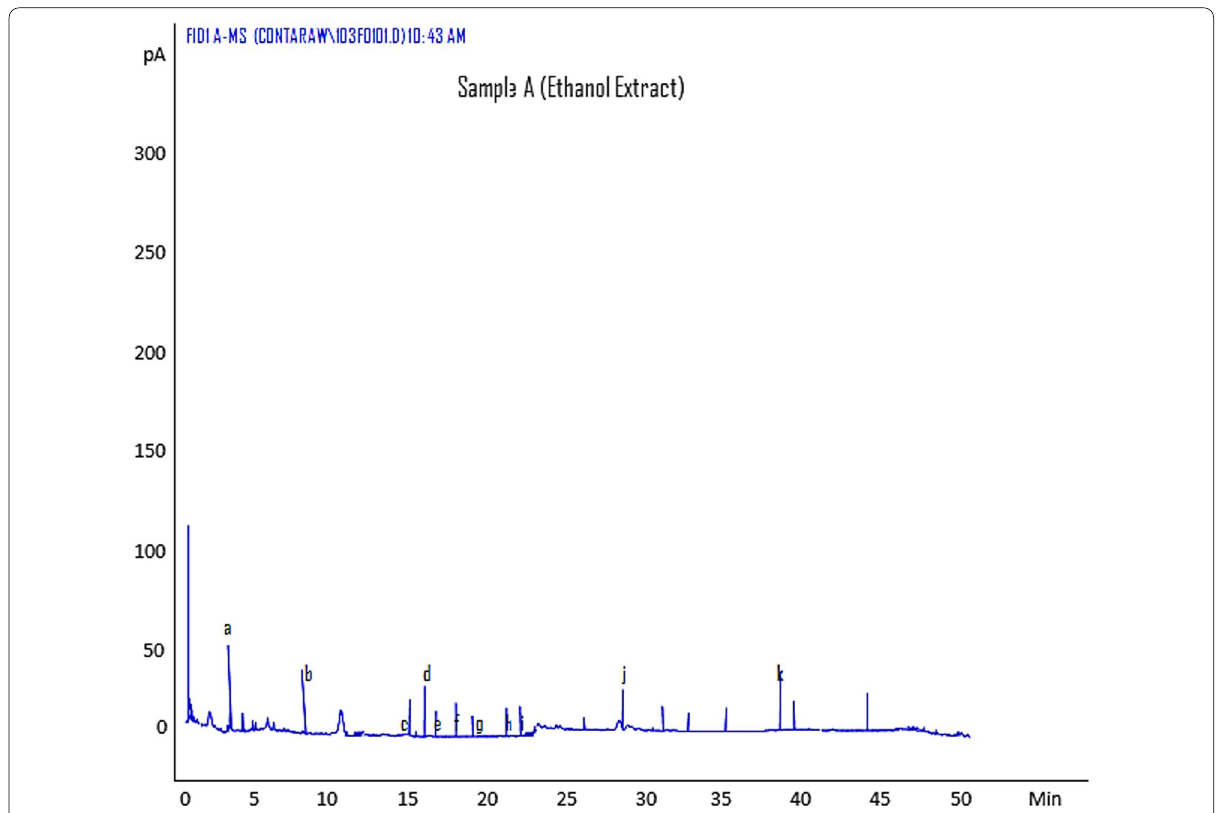
Fig. 1 Gas chromatography–mass spectroscopy chromatogram of Moringa oleifera leaf ethanol